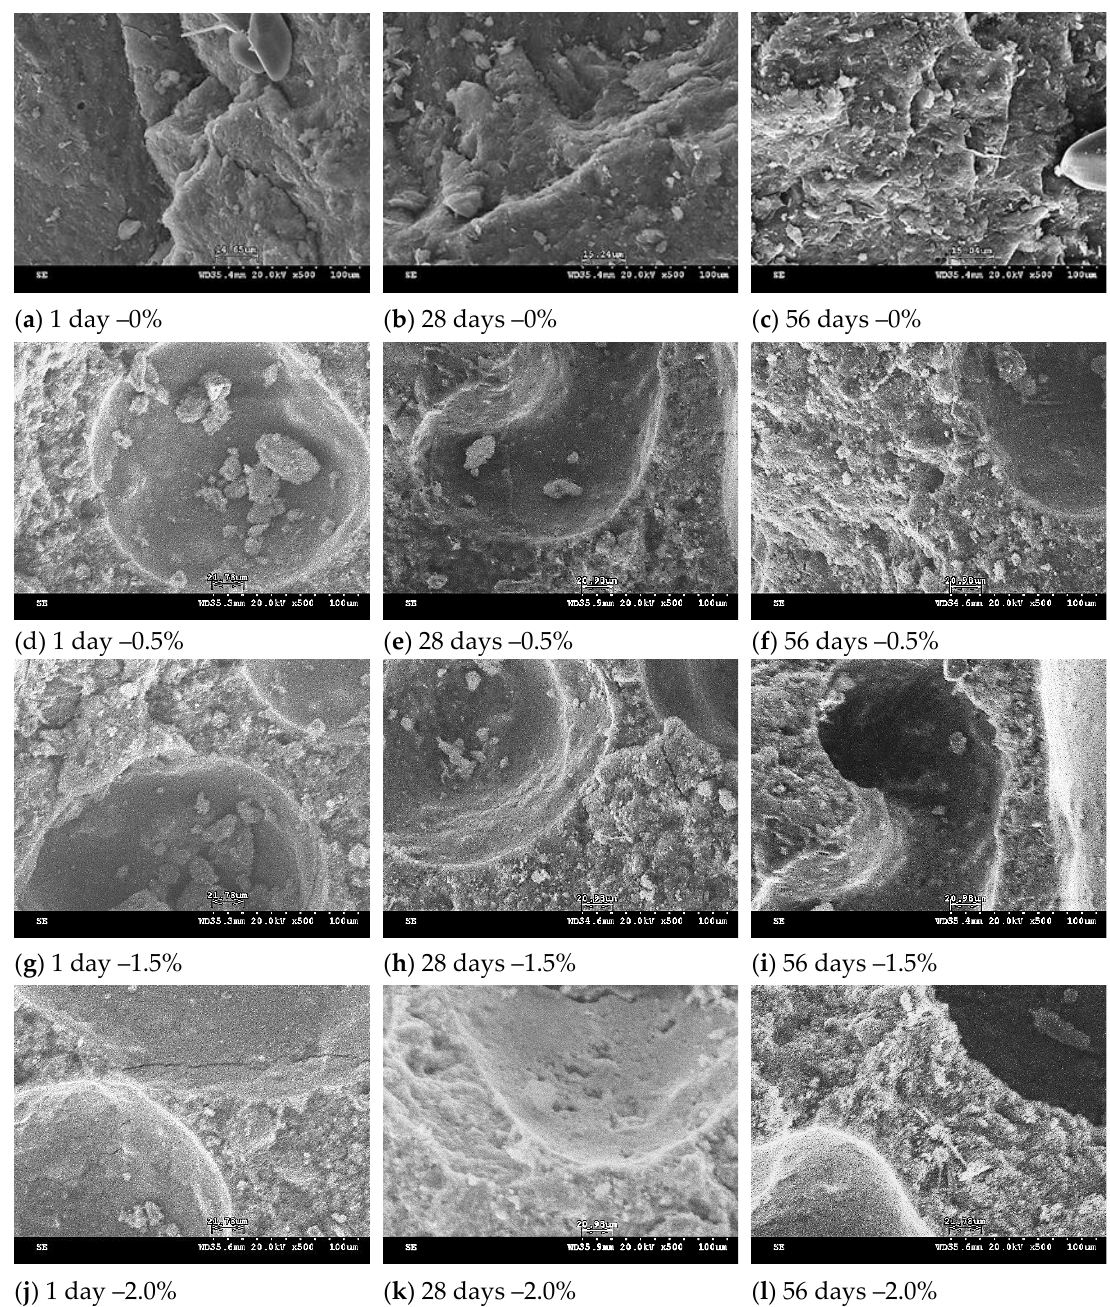
Figure 6 Figure 6. SEM micrograph of lightweight FGPs. (Replacement level = 0%). H ( g – i ) 1.5% and ( j – l )